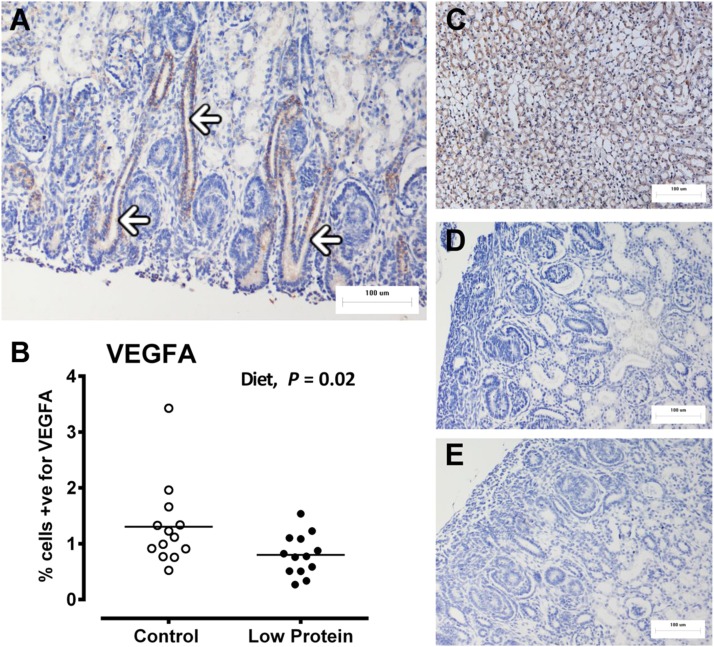
Fetal kidney angiogenic potential, measured as VEGFA, is blunted by maternal LP diet. Fetal kidney angiogenic potential was indirectly determined using immunohistochemistry and quantification of cells positive for VEGFA. A) Representative micrograph of the nephrogenic zone: VEGFA staining is brown; white arrows indicate developing collecting ducts. B) Dot plot of individual data points for control and LP-exposed fetuses (control: male, n=8; females n=7; LP diet: male, n=8; female, n=8). C) Positive control, mouse kidney. D, E) Negative controls, omission of primary antibody (D) and rabbit IgG isotype control (E). All micrographs were taken at ×200. Data were analyzed by the general linear mixed model for the fixed effects of diet, sex, and their interaction term (diet×sex) using Genstat 15. NS, nonsignificant. Values of P < 0.05 were considered significant.